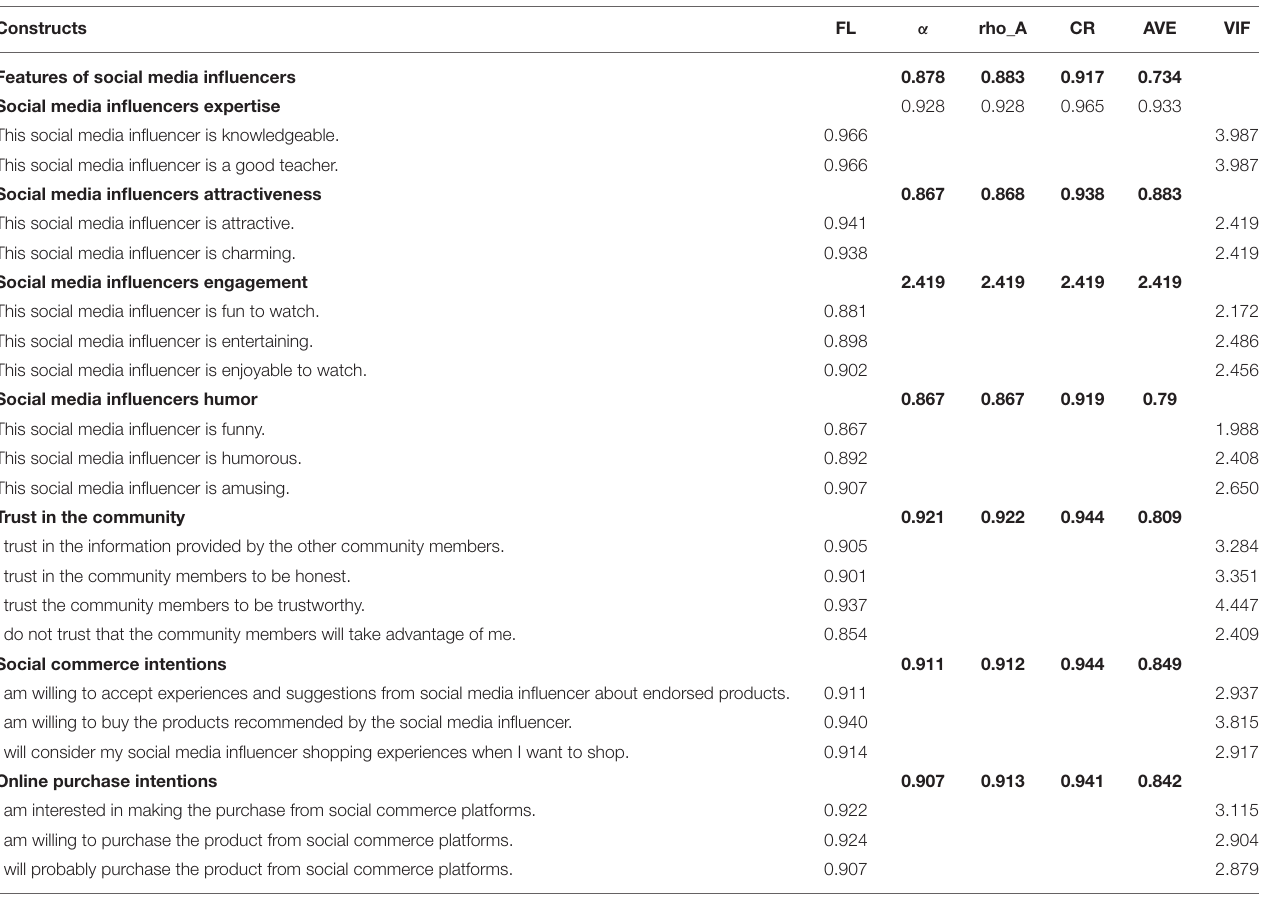
TABLE 3 | Constructs, reliabilities, validities, and variance inflation factor.